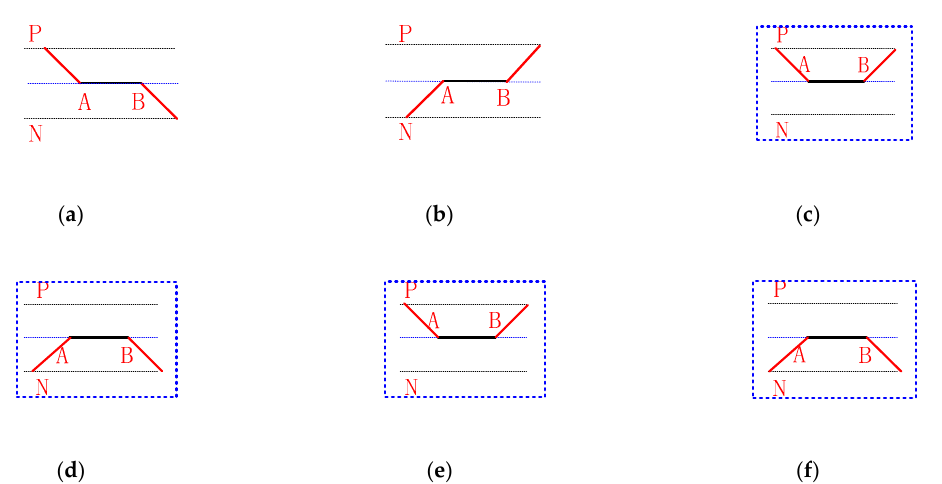
Figure 20. Six modes based on H4 topology under DFUSPWM. ( a ) PC mode; ( b ) NC mode; ( c ) PFT mode; ( d ) PFB mode; ( e ) NFT mode; ( f ) NFB mode.